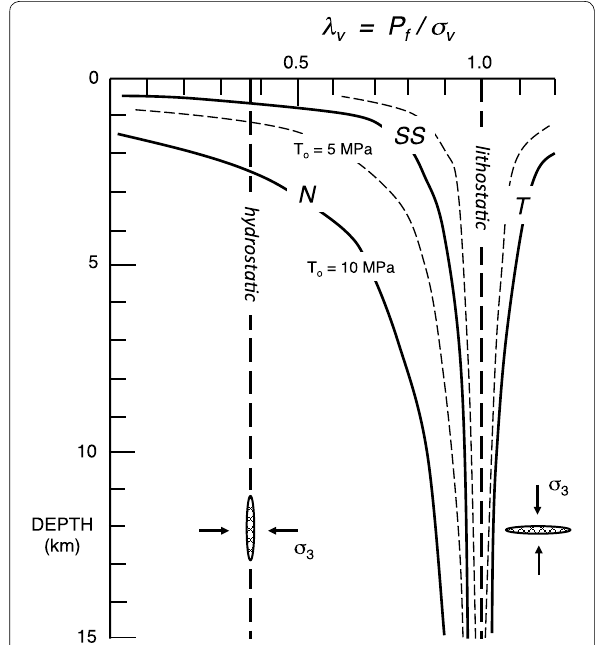
Fig. 3 Plot of the pore-fluid factor, λ v P f / σ v , required for hydraulic = extension fracturing versus depth for the three basic stress regimes with σ v σ 1 (normal fault regime), σ v σ 2 (strike–slip fault regime = = with σ v 0.5 ( σ 1 σ 3 )), and σ v σ 3 (thrust fault regime) following the = + = methodology of Secor (1965). Maximum differential stress limited by tensile strengths, T o 5 MPa (average sedimentary rock) and 10 MPa = (competent sedimentary rock) (Lockner 1995). Adapted from Fig. 2